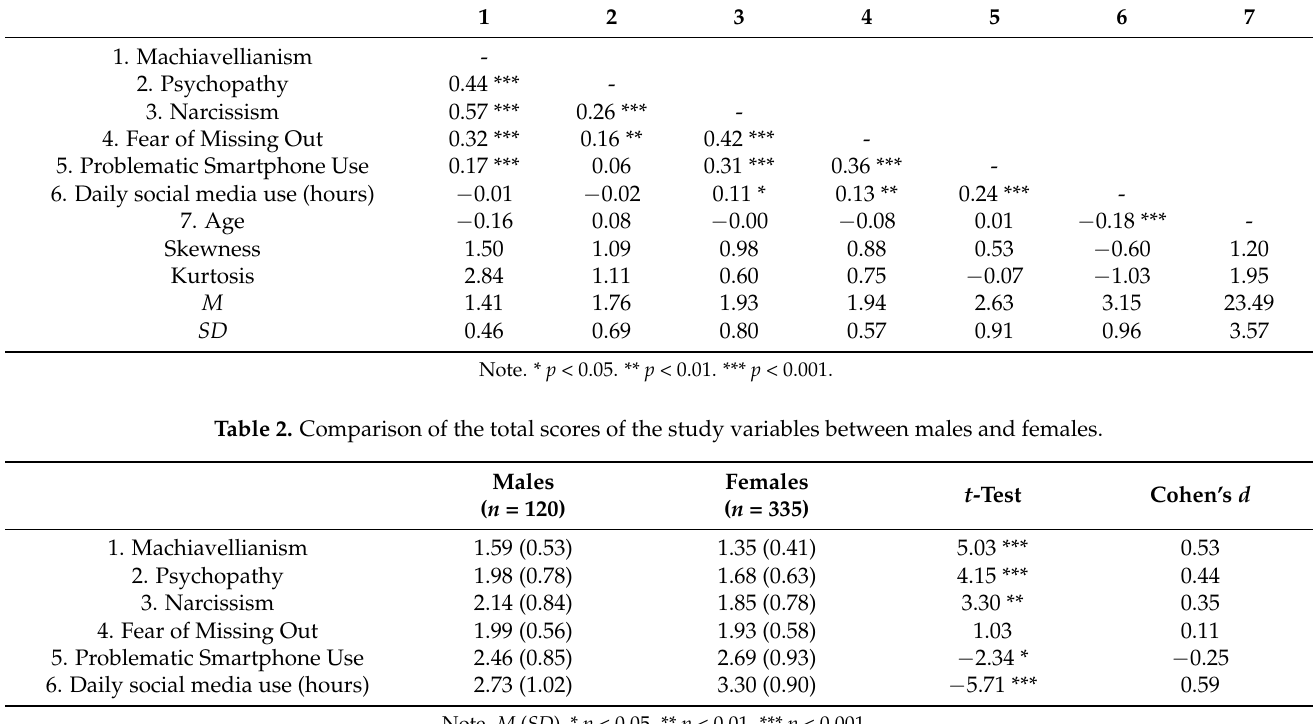
Table 3. Mediation analysis, total, indirect, and direct effects with standardized estimates among the whole sample.